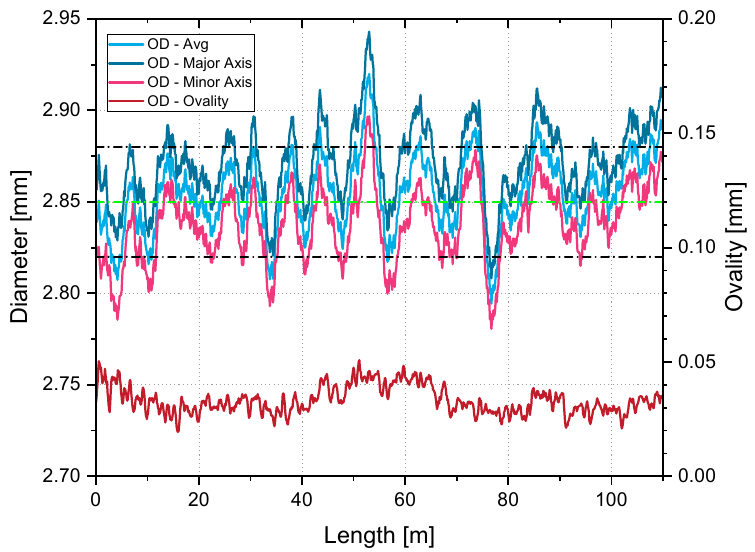
Figure 5. Filament outer diameter with size tolerances at 2.825 mm and 2.875 mm and ovality.